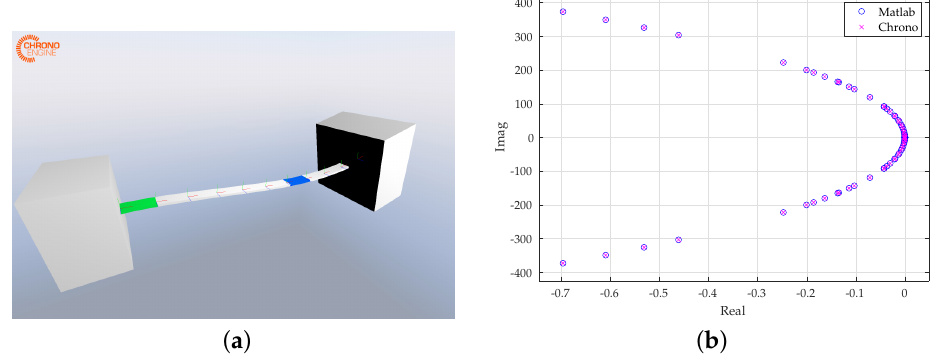
Figure 1. Cantilever Test. ( a ) Cantilever Models. ( b ) Cantilever Eigenvalues. Table 2. Test beams